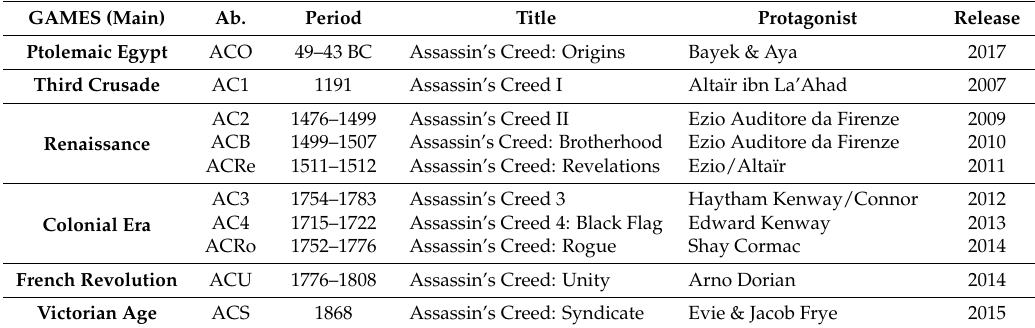
Table 1. Primary games. Overview of primary games within the Assassin’s Creed franchise, including in-game time frame, dramatic period, main protagonists, and release dates. The games are listed in the order of the game-internal time